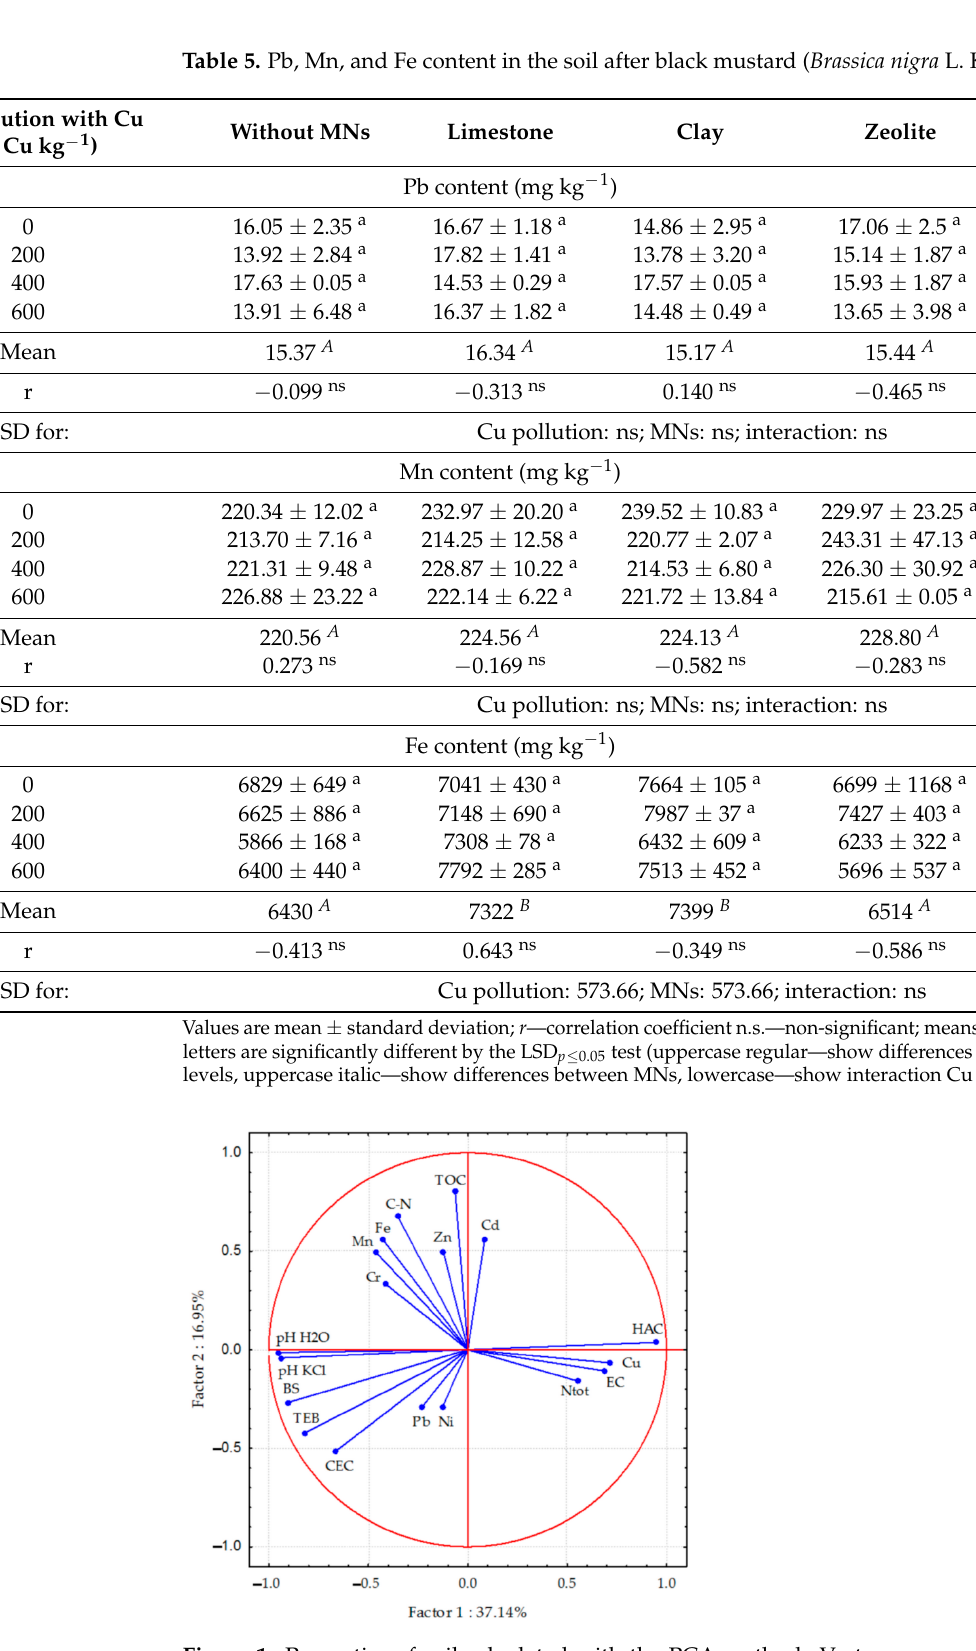
Figure 1. Properties of soil calculated with the PCA method. Vectors represent acidity, sorptive properties, content TOC and total-N, C:N ratio, and content of trace elements. Table 6. Pearson’s simple correlation coefficients ( r ) between soil properties and trace metals content in the soil after black mustard ( Brassica nigra L. Koch) harvest.